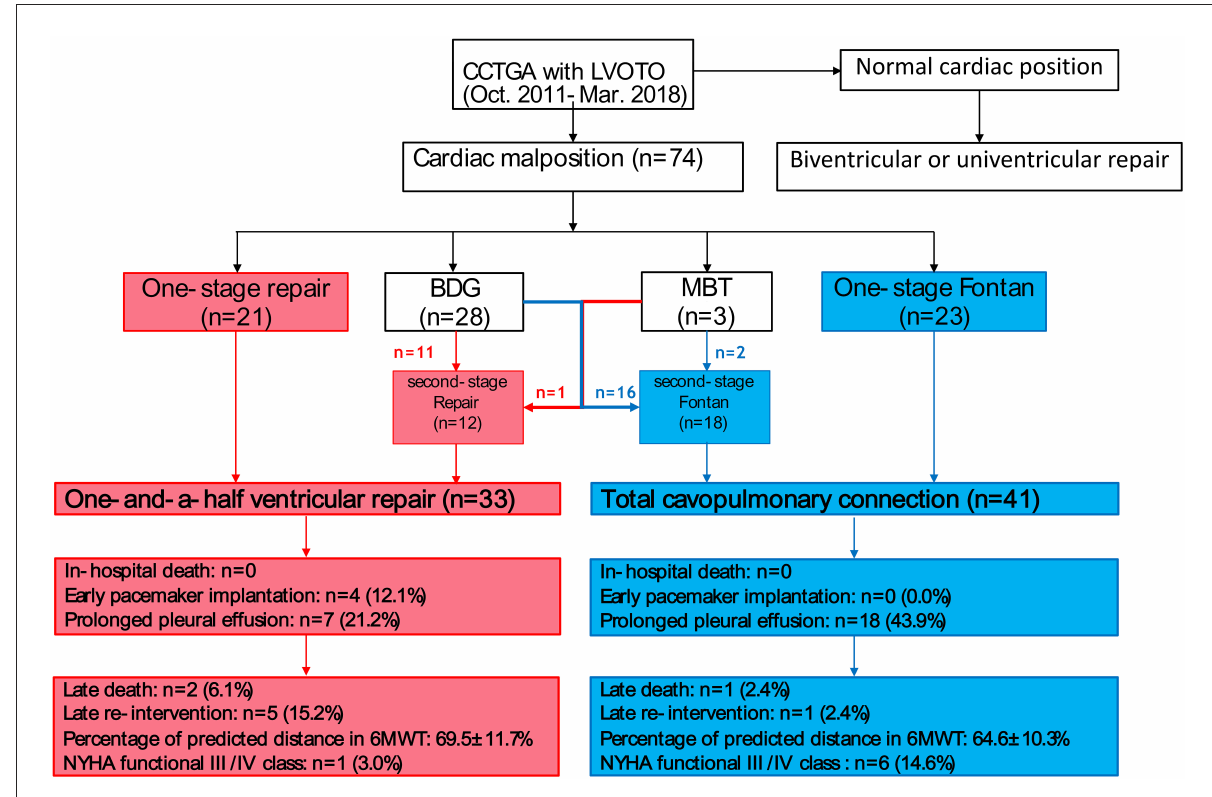
FIGURE1 Graphical flow chart of surgical process: The red boxes and arrows indicate the surgical outcome of one and a half ventricular repair and the blue one the outcome of the Fontan pathway results in congenitally corrected transposition of great arteries (CCTGA).